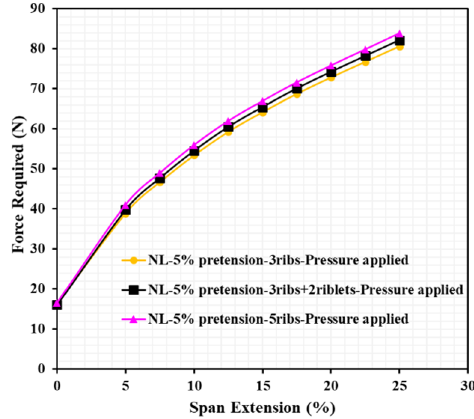
Figure 14. Actuation force for different geometric models.